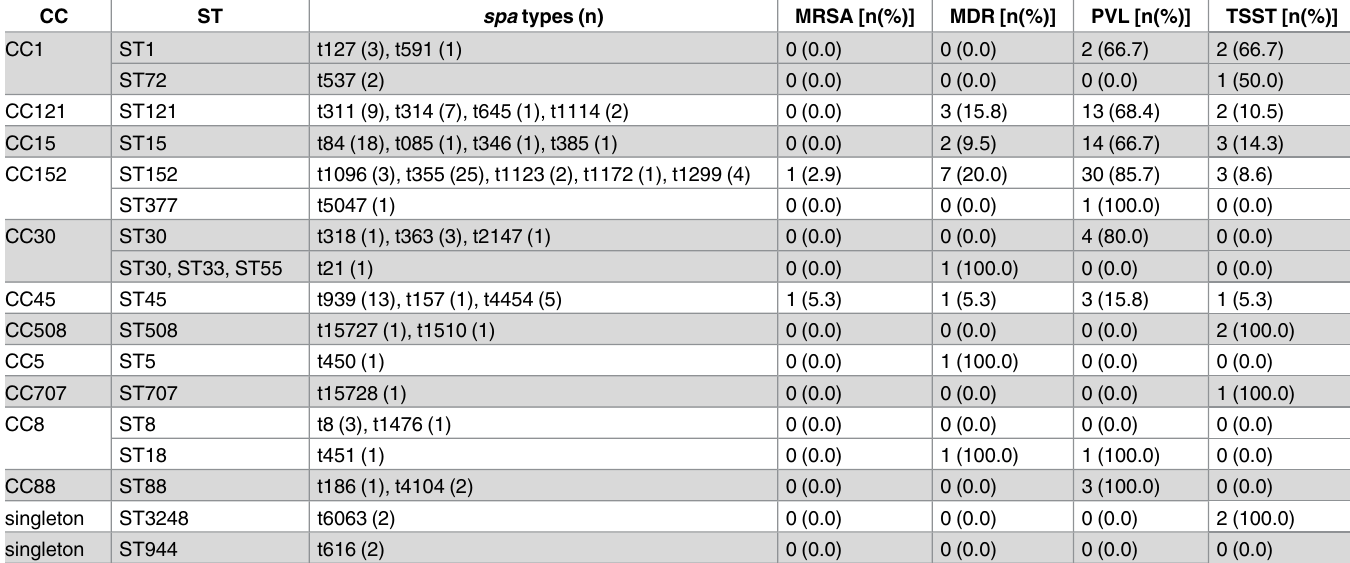
Table 2. Characterization of nasal Staphylococcus aureus isolates (n =